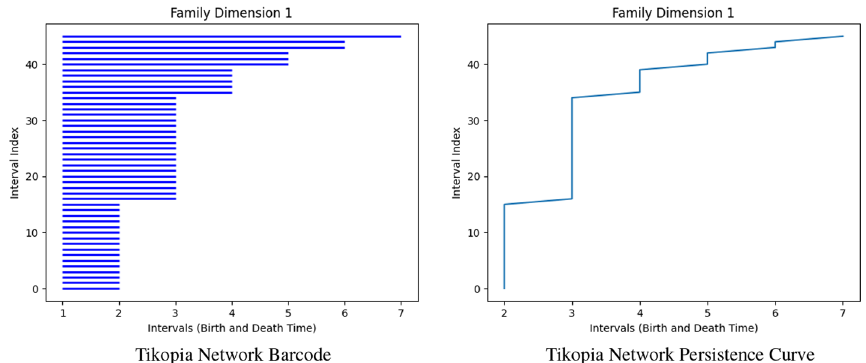
Fig. 7 Left: The barcode of the Tikopia genealogical network in dimension 1 is shown. The individual bars are formed from the persistence intervals given in Table 1. Right: The associated persistence curve for the Tikopia network in Fig. 1 is